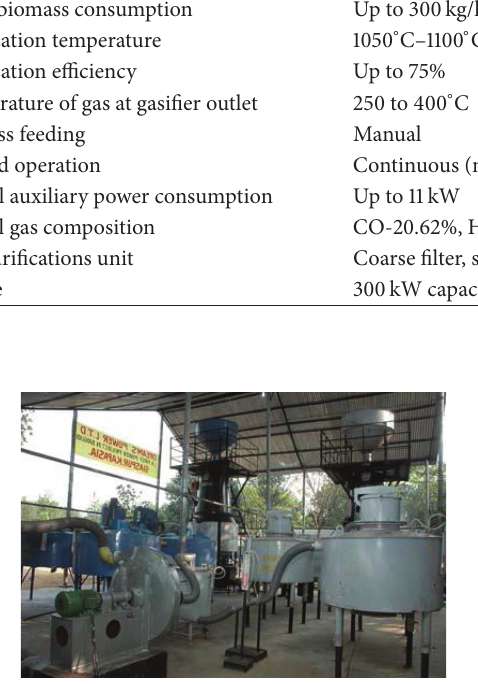
Figure 2: Rice husk fired 250 kW gasifier power plant at Kapasia, Bangladesh